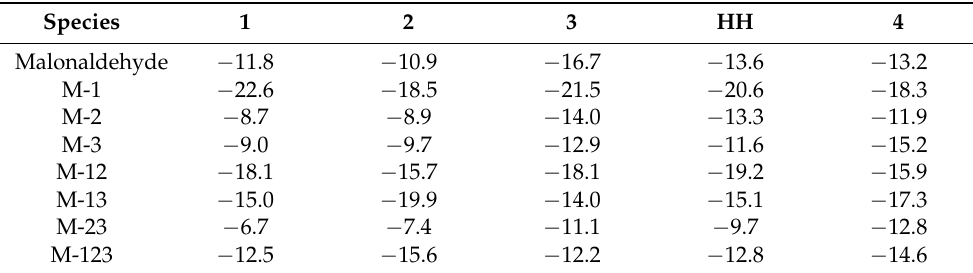
Table 3. Interaction energies of O–H ··· O hydrogen bonds (kcal/mol); 1, 2, 3, 4 and HH correspond to configurations presented in Figure 4 that are referred systems to calculate energies.